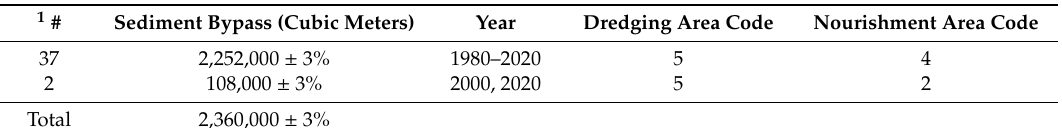
Table 4. Volume of sediments redistributed as sediment transfer during the 1980–2020 timespan along the considered sector of coast, sorted by the nourishment area code. Refer to Table S2 for a detailed list of each transfer intervention.